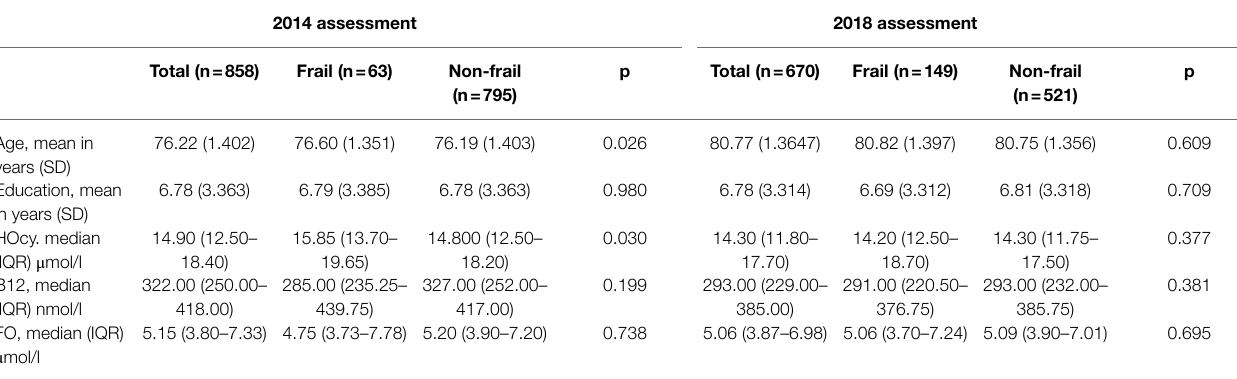
TABLE 3 | Characteristics of the 2014 and 2018 subjects, recruited for longitudinal analyses comparing the Frail and the Non-frail